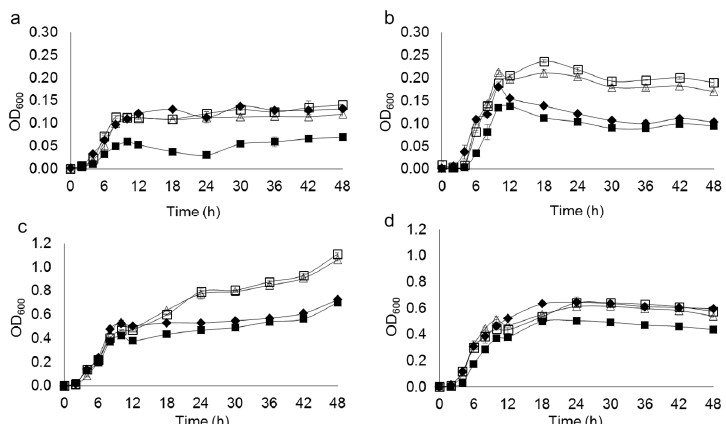
Figure 2. Growth of bacterial isolates in NB ( a ), NB supplemented with 2% urea ( b ), TSB ( c ), and TSB supplemented with 2% urea ( d ); Lysinibacillus sp. 2.2 ( △ ), L . fusiformis 3.7 ( □ ), L. xylanilyticus 4.3 ( ♦ ), L. fusiformis 5.1 ( ■ ). Values are mean ± SD. The SD value was shown in supplementary Table S1.